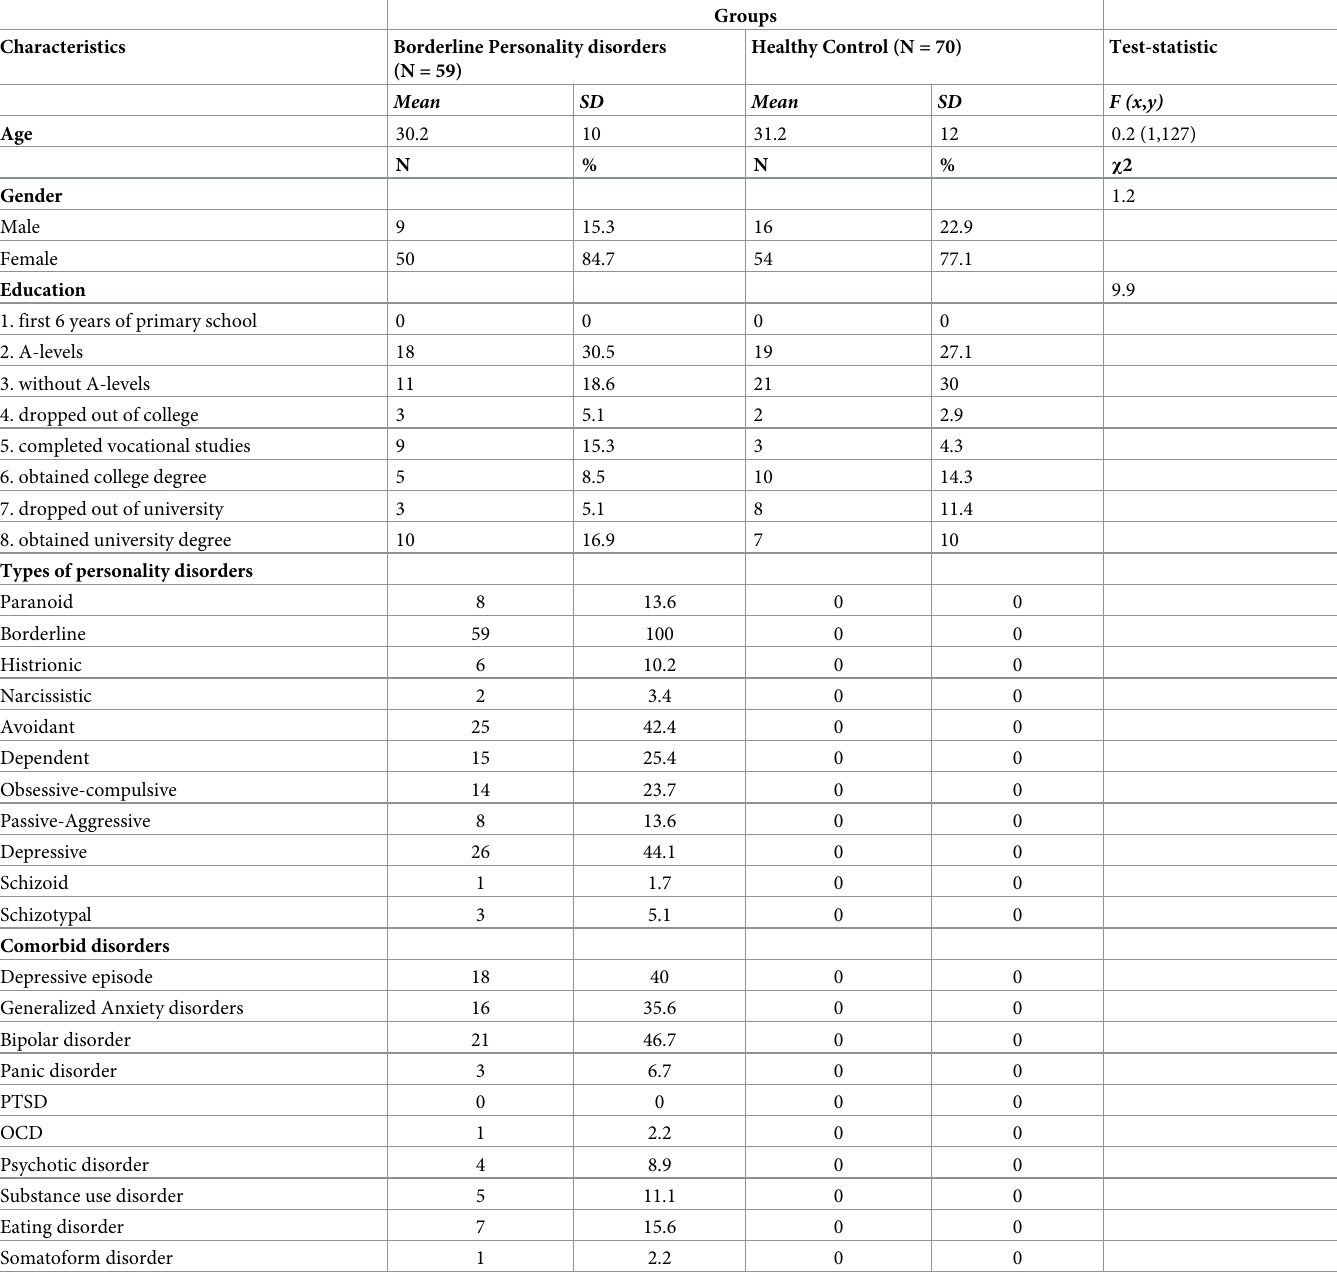
Table 2. Sociodemographic and clinical variables of patients with borderline personality disorder and healthy comparison subjects.